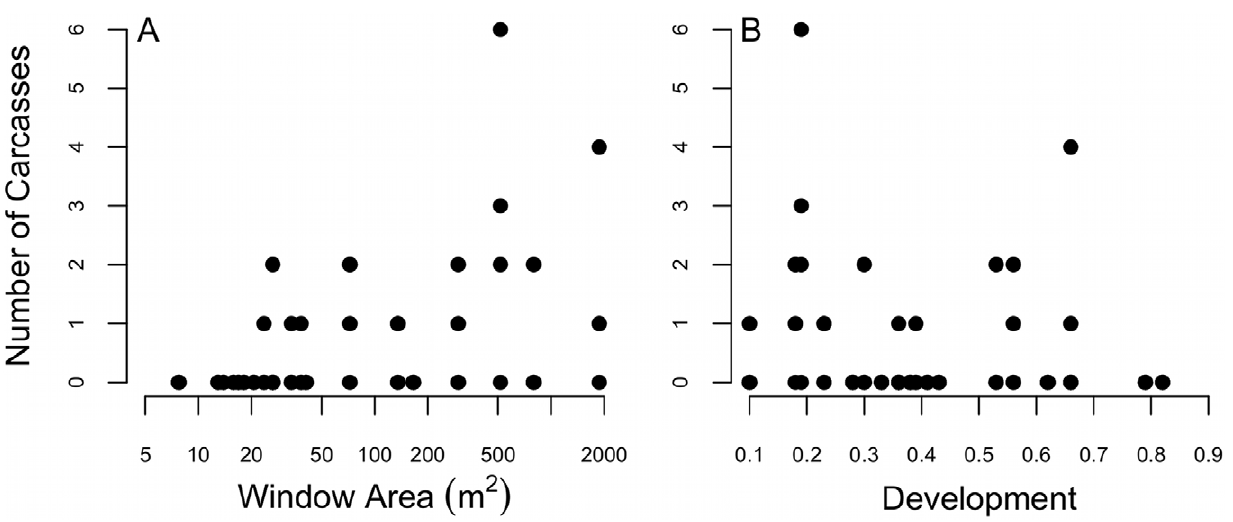
Figure 3. Factors driving bird-window collisions. The most-supported model explaining mortality included the effects of (A) window area and (B) development (% impervious surfaces) (see Table 3).